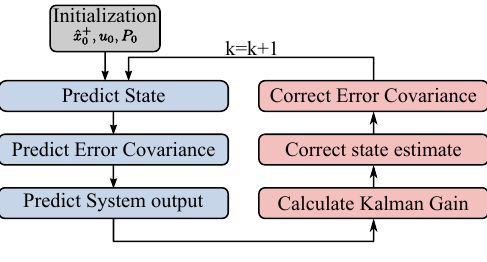
Figure 9. General steps of a